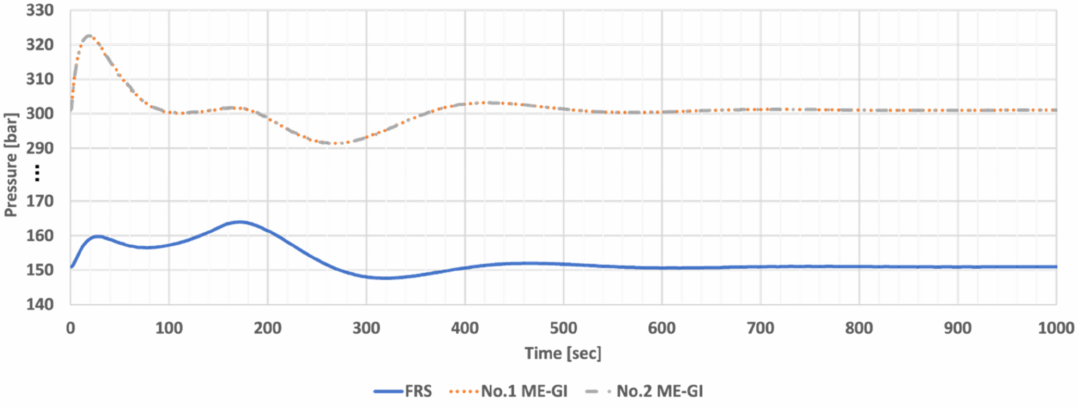
Figure 15. Pressure of each line when two engines are tripped.